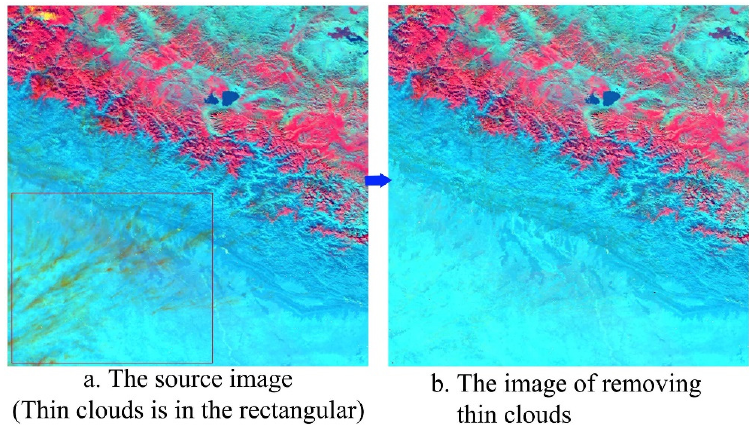
Figure 5. The high-cloud-removed image ( a ) and its source image ( b ).